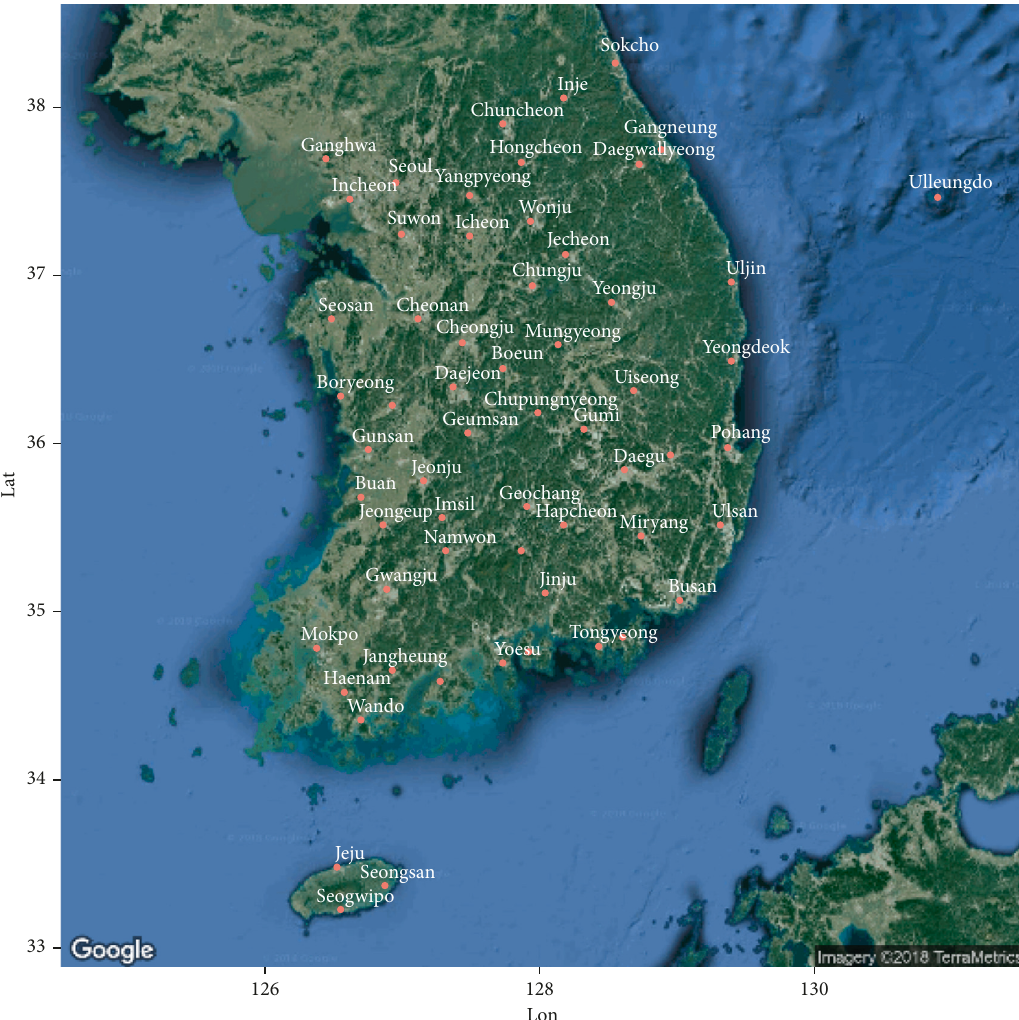
Figure 2: ASOS 60 weather stations in South